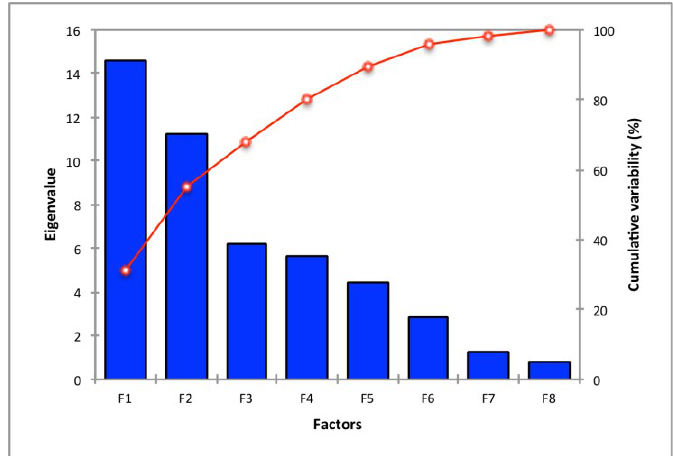
Figure 4. A scree plot showing the relative eigenvalues for the principle components generated for the measured variables.